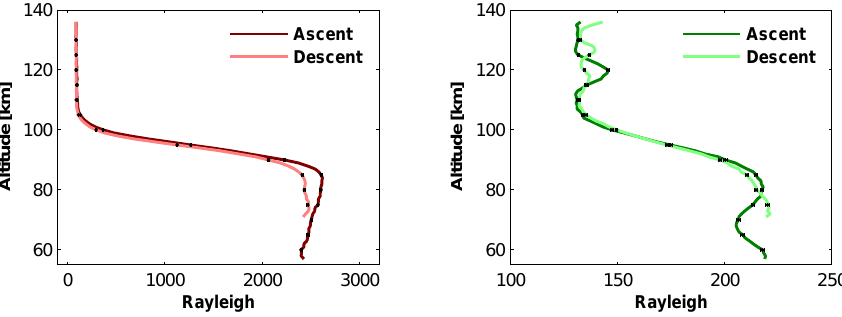
Fig. 2. The measured column emission in units of Rayleigh, R (the radiance in photonscm − 2 str − 1 s − 1 multiplied by 4 π × 10 − 6 ) , for the (0-0) band of the O 2 A-band system centred at 761.9nm (left panel) and the NO 2 continuum at around 540nm (right panel) as a function of altitude for both the ascent (darker colour) and descent (lighter colour) part of the flight. The profiles are interval averaged with 1km vertical resolution and the error bars show the error of the mean. Note that the background sky emissions have not been subtracted (i.e. the signal above the nightglow layer does not tend to zero). Note also the weak continuum emission of ∼ 90R (5.4Rnm − 1 ) compared to the ∼ 130R (7.8Rnm − 1 ) background.